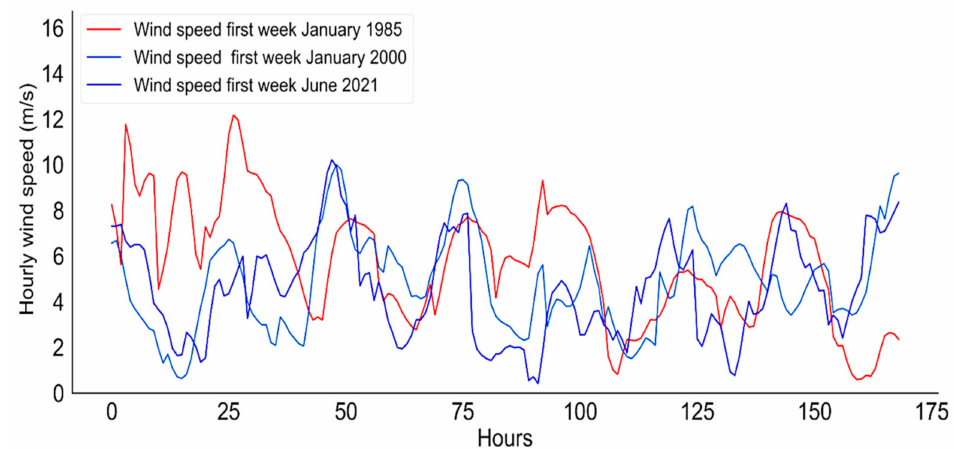
Figure 14. Hourly intervals historical performance of the wind speed.